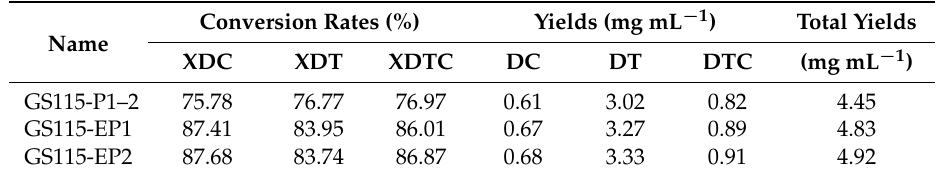
Table 1. Conversion rates of 7- β -xylosyltaxanes and the yields by the recombinant yeast